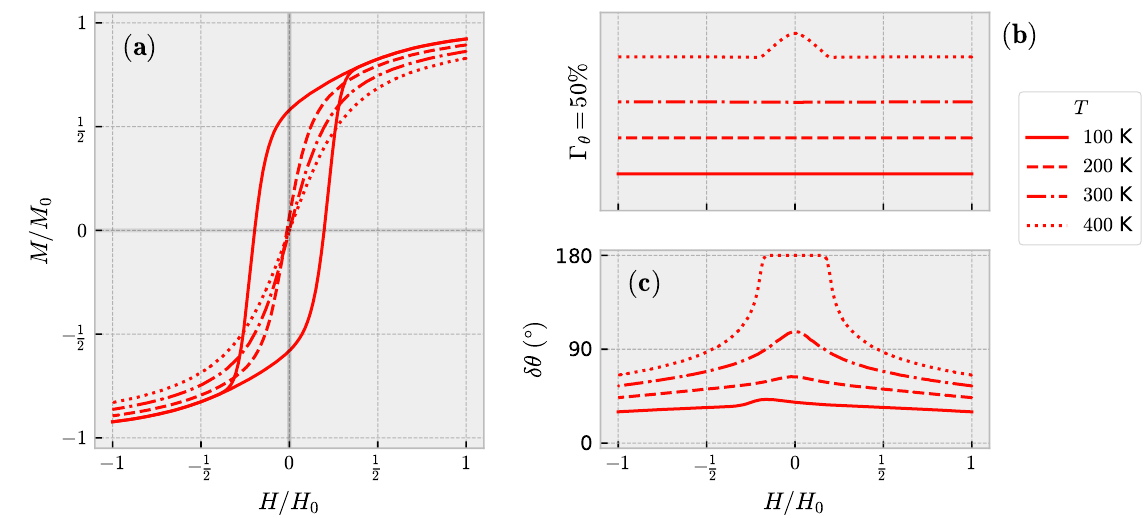
Figure 7. ( a ) Reduced magnetization, ( b ) acceptance rate and ( c ) cone aperture as a function of the external magnetic field for Γ θ = 50%. Blocked and superparamagnetic behaviors are obtained depending on